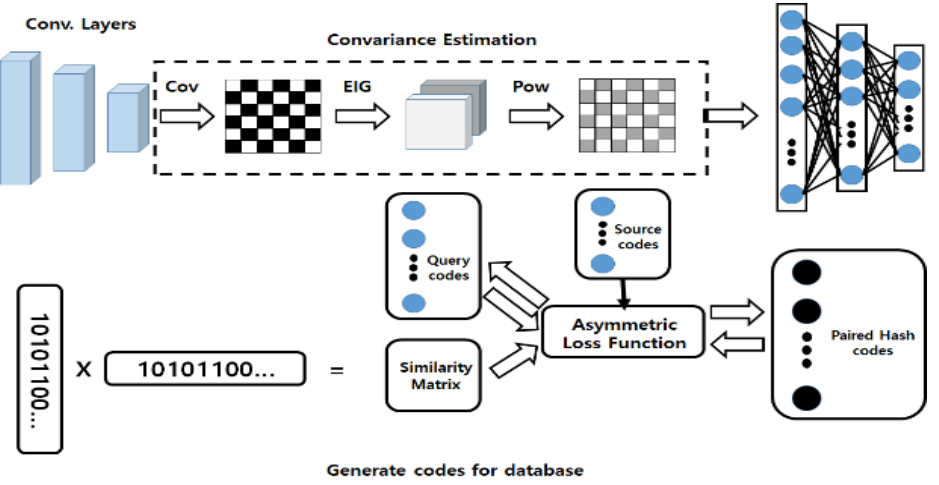
Figure 4. Block Processing for hash processing of IoT data.